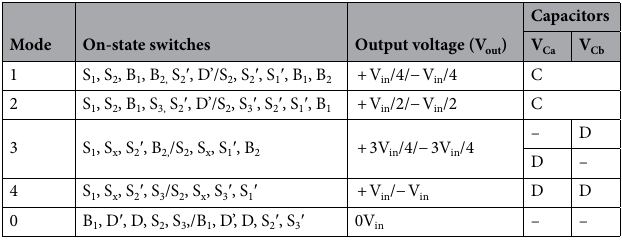
Table 2. Switching sequence of each level. C charging, D discharging, – no